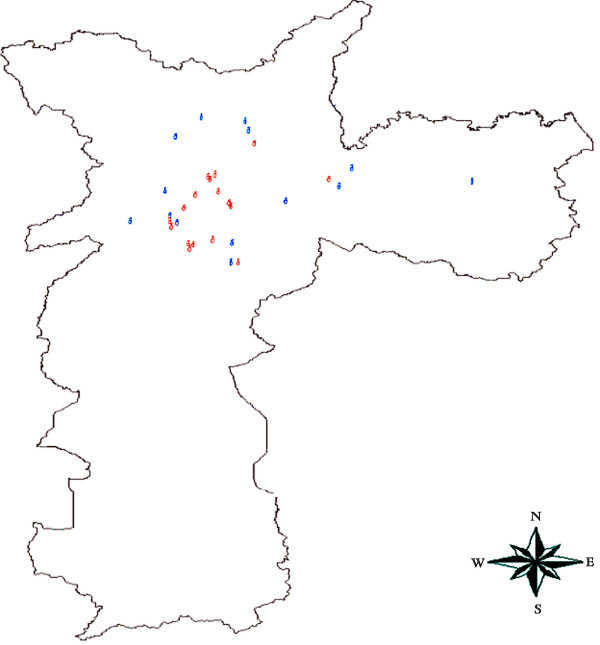
Distribution of the passive samplers sites in different regions of the City of São Paulo.